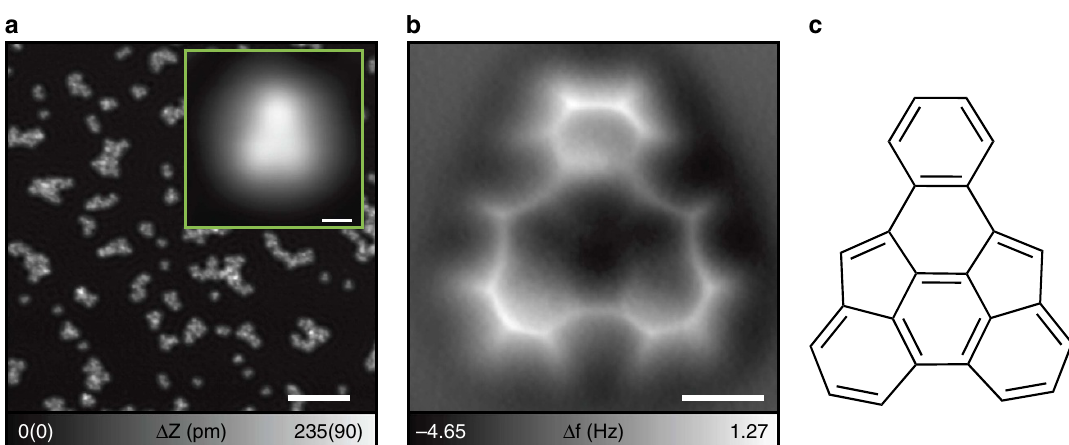
Figure 4 | Third reaction by annealing at 400 (cid:2) C. ( a ) STM topography of tDAB on Cu(111) after annealing at 400 (cid:2) C. Inset shows the close view. Scale bar (inset), 10nm (500pm). ( b ) AFM image, measured at constant height. Scale bar, 300pm. ( c ) Chemical structure of the product. Measurement parameters: V tip ¼ (cid:2) 200mV and I ¼ 10pA in a . V tip ¼ 0mV and A ¼ 60pm in b .